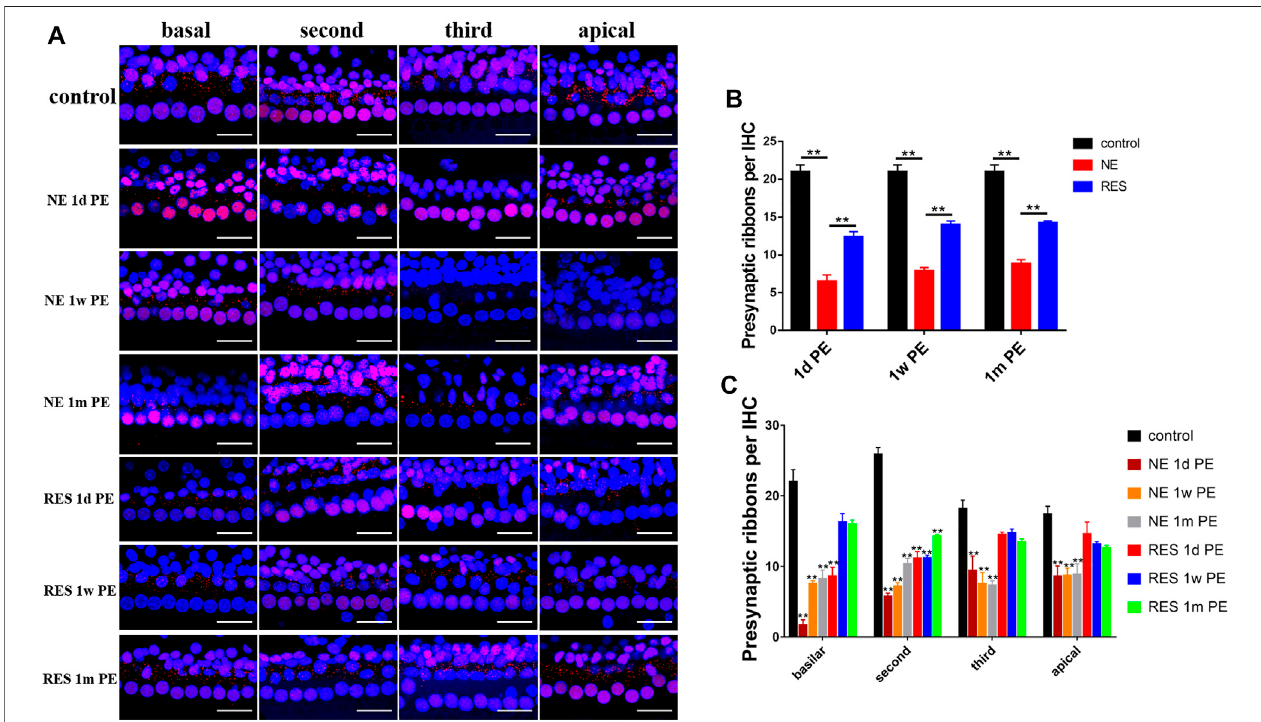
FIGURE 2| Noise induced changes in ribbon density (ribbonsper IHC), the values are presented as themeans ± SEM. (A) Representative images showing ribbon changesby the noiseexposure. Scalebar =100pixel. (B) The ribbon density at different time after noise. n =24 locations in each group. (C) Ribbon changesof different turn by the noise exposure. n = 6 in each group. Note: In (B) , * p < 0.05, ** p < 0.01, as compared with NE group. In (C) , * p < 0.05, ** p < 0.01, as compared with control